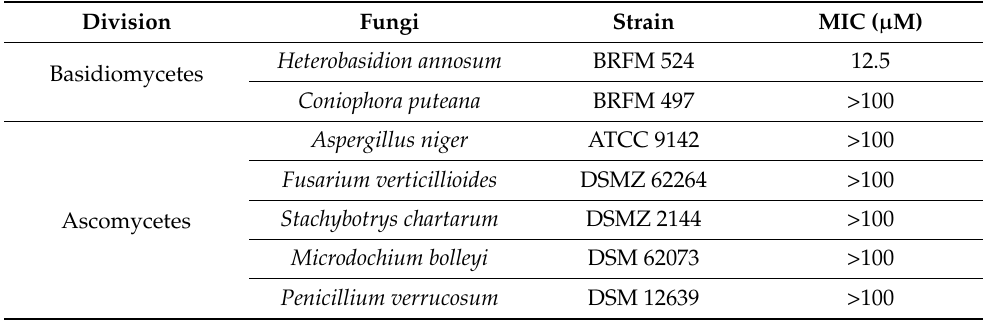
Table 1. In vitro antifungal activity of RumC1. Activity spectrum of RumC1 against selected As- comycetes and Basiodiomycetes strains. MIC determination was performed in independent triplicates. Division